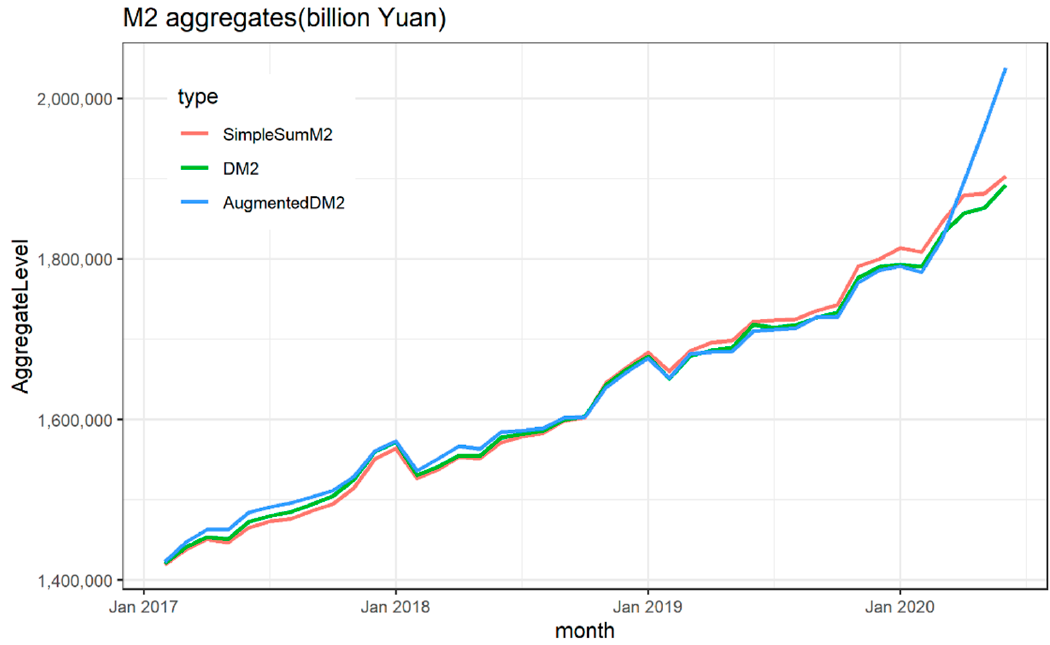
Figure 3. Divisia M2, Consumption Loan Augmented M2 and simple sum M2.